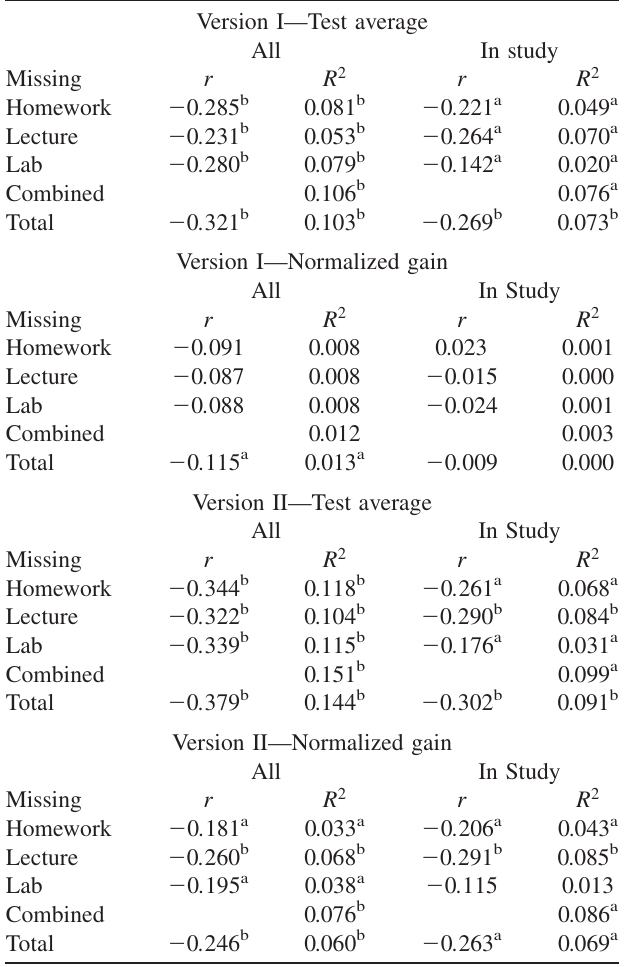
TABLE II. The effect of missed assignments on performance. For version I—All, N ¼ 455 students are included in correla- tions with test average, and N ¼ 377 students are included in correlations with normalized gain. For version II—All, N ¼ 364 students are included in correlations with test average, and N ¼ 313 students are included in correlations with normalized gain. For version I—In study, N ¼ 194 students are included in correlations with test average and normalized gain. For version II—In study, N ¼ 166 students are included in correla- tions with test average and normalized